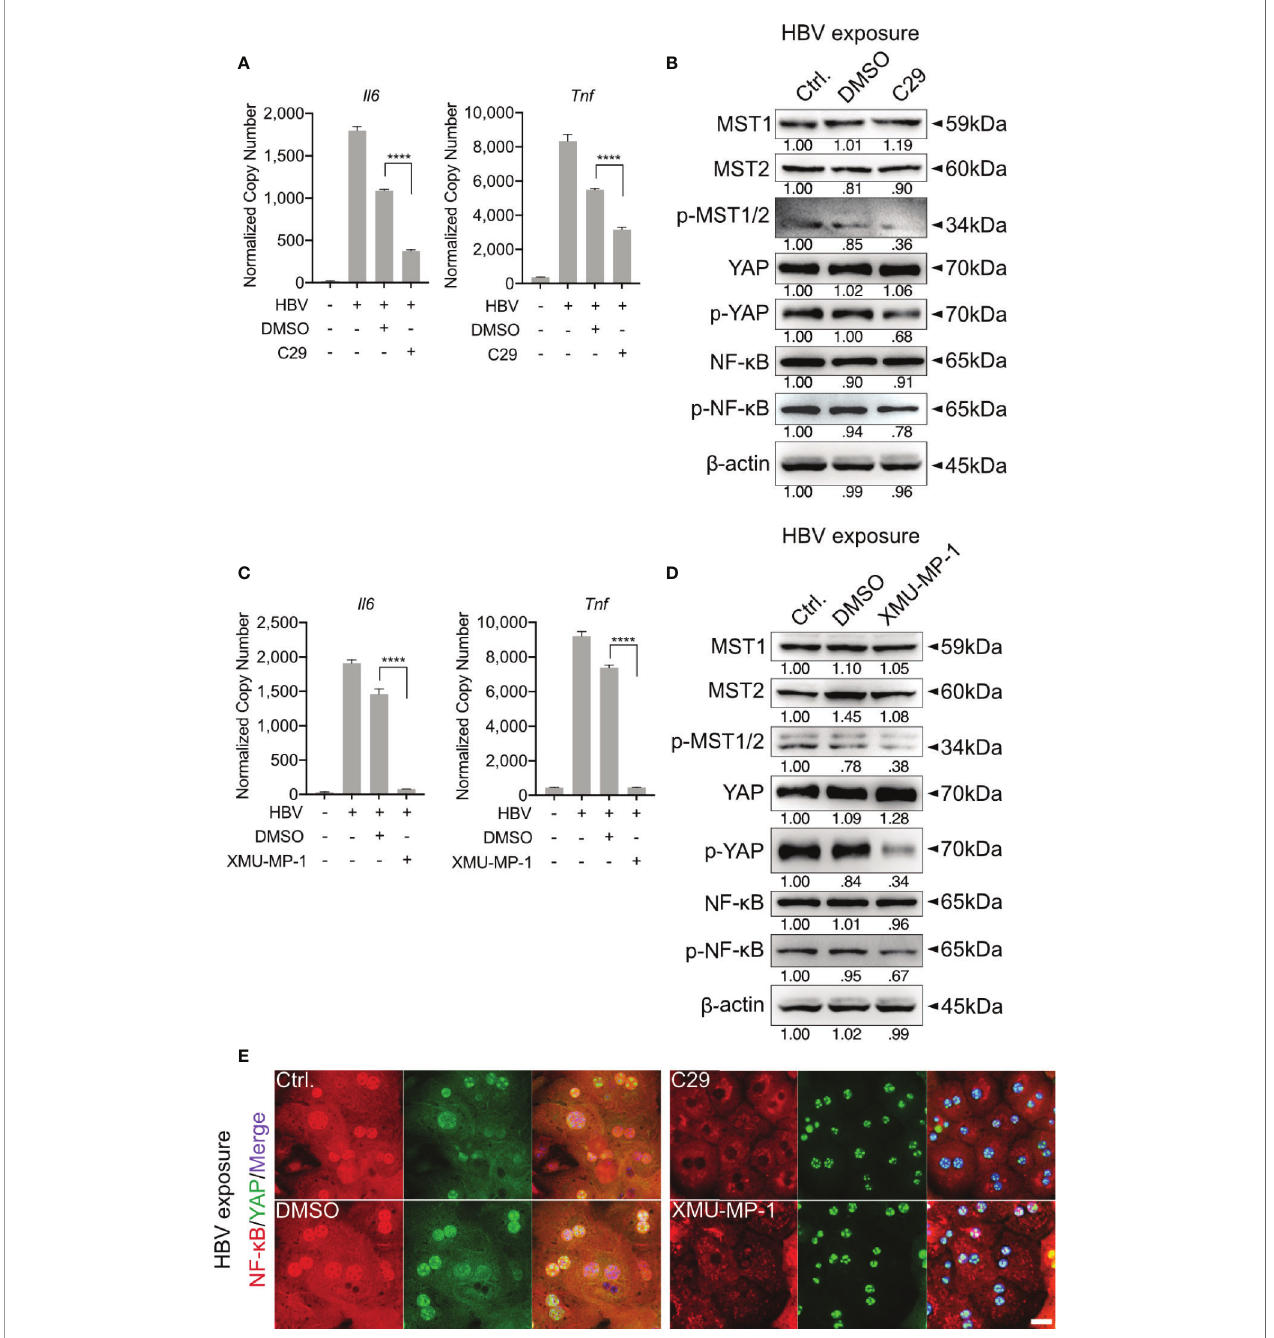
FIGURE 3 | TLR2-mediated activation of Hippo signaling is essential for the control of rapid innate responses after HBV exposure. Primary murine hepatocytes (PMHs) were treated with TLR2 inhibitor C29 [50 m M] or MST1/2 inhibitor XMU-MP-1 [1 m M] for 2h prior to HBV exposure for an additional 2-6h. At 6h quantitative PCR was performed to detect Il6 and Tnf expression in C29-pretreated (A) and XMU-MP-1-pretreated (C) PMHs (normalized to Actb , mean ± SEM, n=3 independent experiments). Western blotting was performed to detect MyD88, MST1/2, phosphorylated MST1/2, YAP, phosphorylated YAP, NF- k B and phosphorylated NF- k B in C29-pretreated (B) and XMU-MP-1-pretreated (D) PMHs 2h after HBV exposure, representatively. Gel images were obtained with ADVANCED Fluorescence and ECL Imager, n=3 independent experiments. ICC staining was performed and visualized using Zeiss AxioObserver.Z1 and Apotome (40x objective) 2h post HBV exposure to indicate YAP (green) and NF- k B (red) localization in PMHs pretreated with C29 and XMU-MP-1. Raw images were subsequently proceeded with Image J software, n=3 independent experiments (E) . ****p <